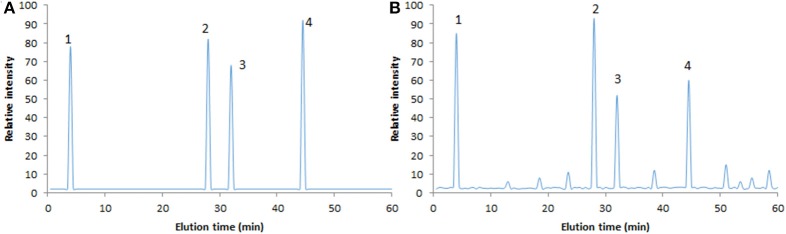
HPLC analysis of AB ingredients. (A) The standards of sucrose, calycosin, Astragaloside IV, and calycosin-7-glucoside. (B) The main ingredients of AB.